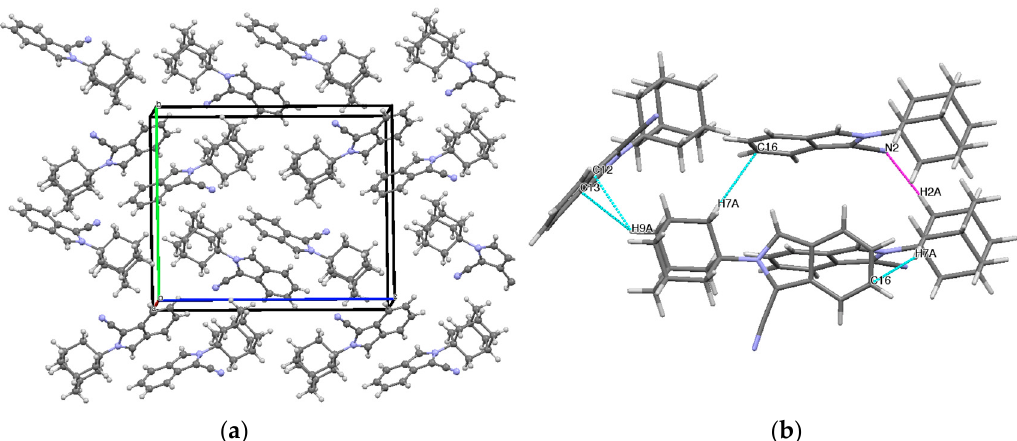
Figure 2. ( a ) The molecular crystal packing of compound 1 viewed along the b-axis. ( b ) Partial crystal packing showing the H-bond (magenta) and C-H ⋯ π (light blue) intermolecular interactions along the c-axis. Table 1. Bond lengths (Å), angles (°), and theoretical calculations of compound 1 . Bond Lengths